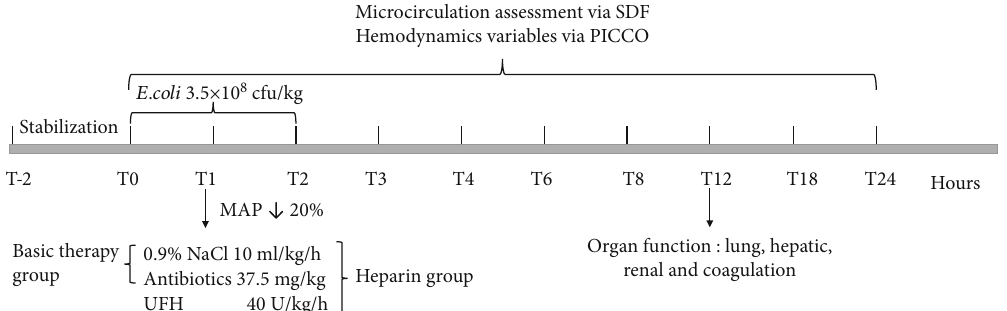
Figure 1: Study design. All animals were stabilized for 2 hours after surgical procedures, and 3 : 5 × 10 8 cfu/kg E. coli was continuously injected from T0 to T2. Hemodynamics and microcirculation measurements were taken over a 24 h period: at baseline (T0), T1, T2, T3, T4, T6, T8, T12, T18, and T24.